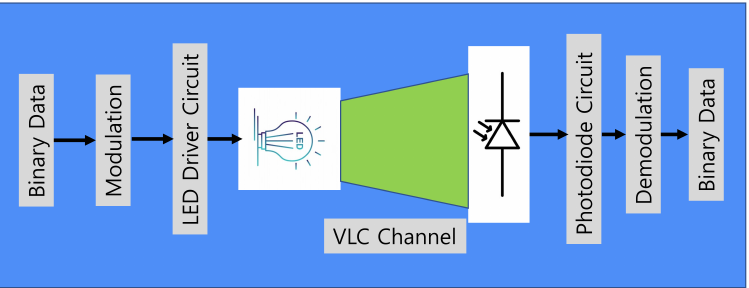
Figure 2. Visible light communication system and